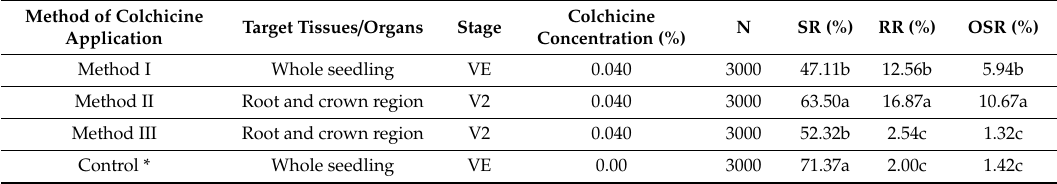
Table 1. Comparison of success rates derived from Methods I, II, and III of colchicine application to maize haploids.